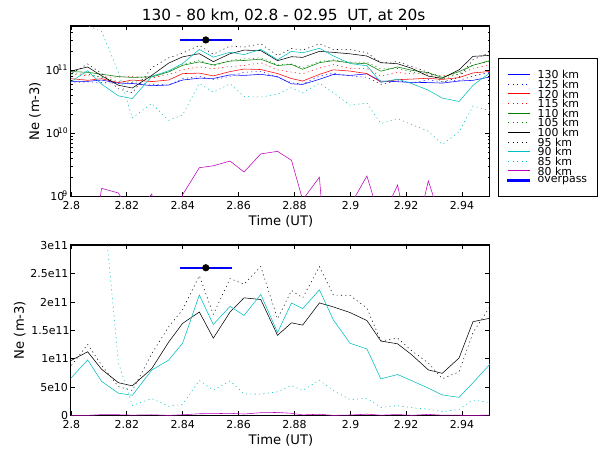
Fig. 16. Count rate of the > 30keV, 0 ◦ and 90 ◦ telescopes, during the overpass. For comparison, the triangles show “equivalent count rates”, obtained by multiplying the square of the absorption esti- mated along the track at 3s intervals by the factors 2.10 5 and 4.10 4 (see